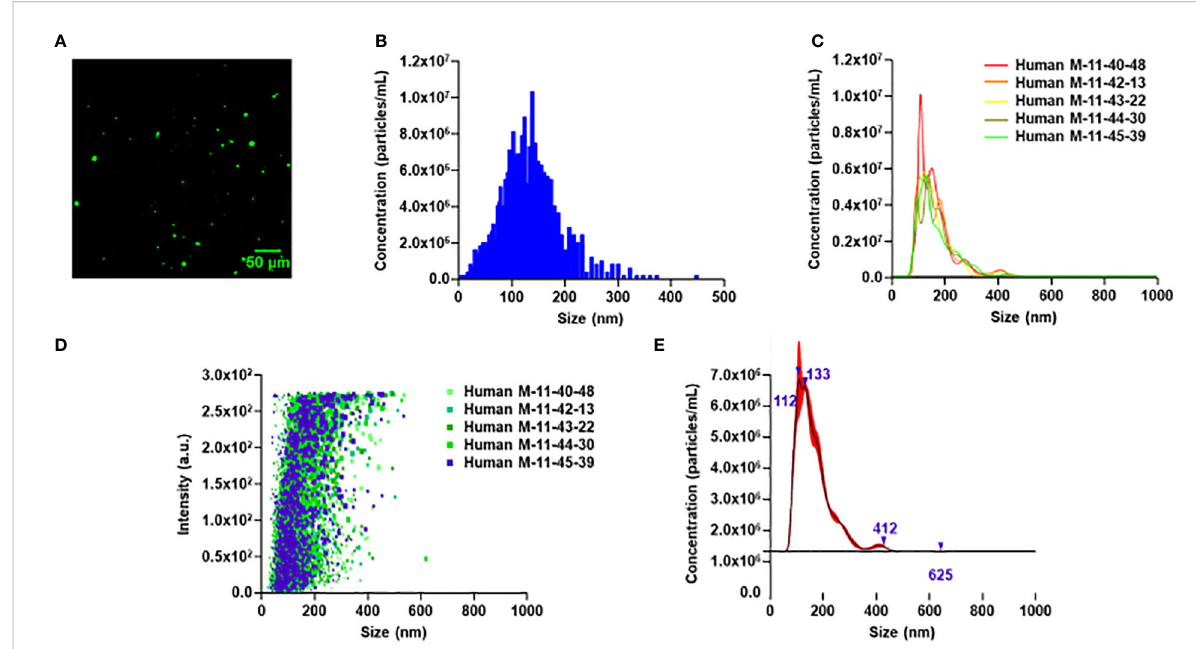
FIGURE 1 Characterization of human PBMC-derived M1 vesicles. (A) Wide fi eld image of human M1 MEVs loaded with fl uorescein. (B) Particle tracking analysis for human M1 MEVs. 2.4 x 10 7 human M1 macrophages generated 2 x 10 10 vesicles. (C) Finite track length adjustment (FTLA)/size graph